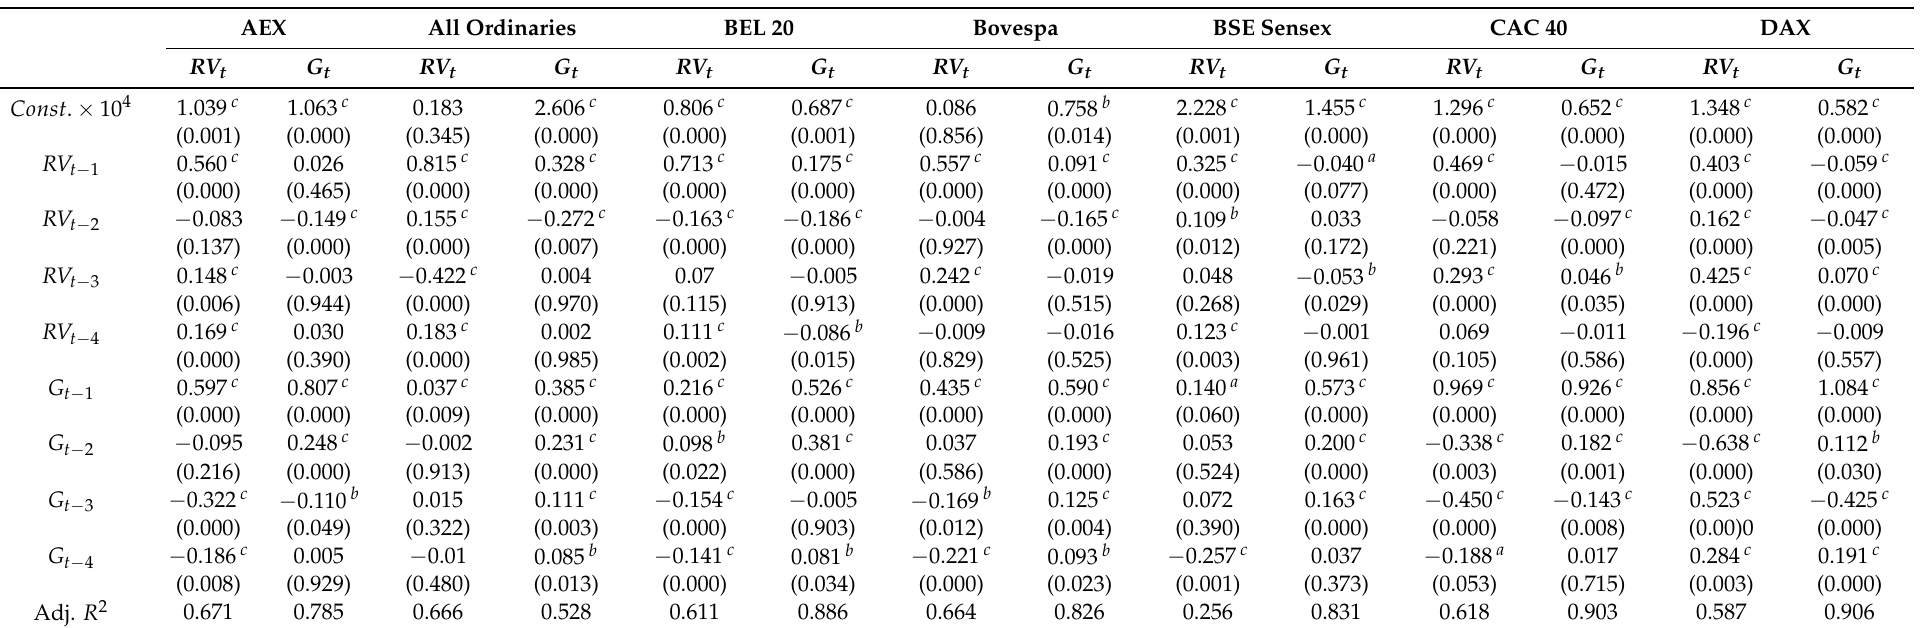
Table 4. VAR estimation